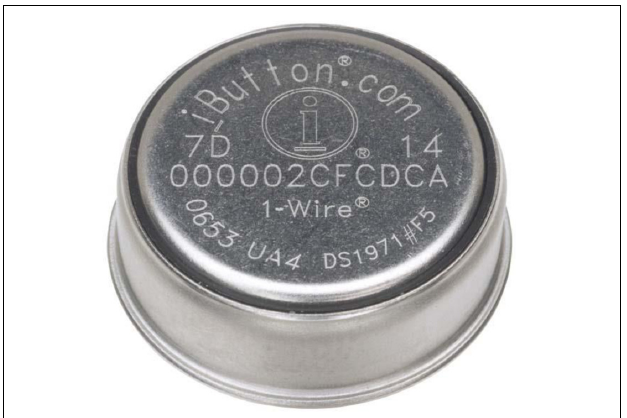
FIGURE 2 | BlueMaestro TempoDisc (left panel) and BlueMaestro TempoDisc in a Fitbug wristband (right panel) as used in our